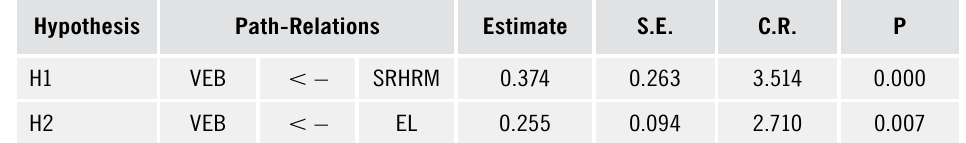
Table 3. Estimates on direct effects